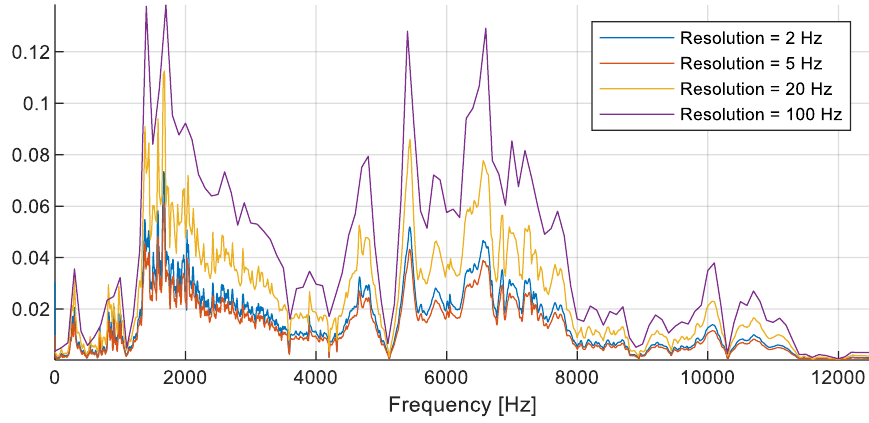
Figure 6. Spectrum of pulses with different length (Y-axis manually scaled).